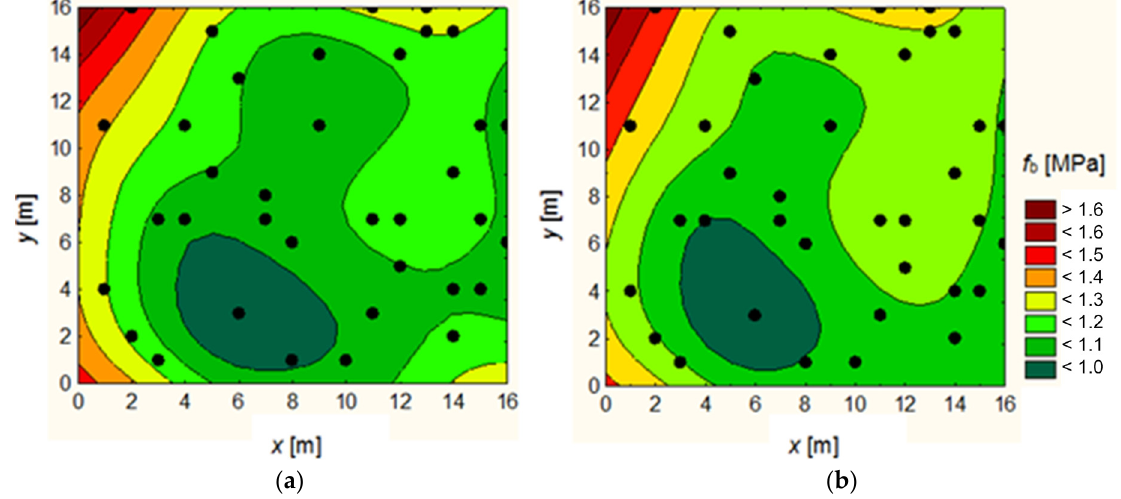
Figure 7. Comparative maps of the value of the f b , based on validation results yielded by: ( a ) the pull-off method; ( b ) the ICA-ANN model (the symbol “ • ” represents a randomly-selected test point used for validation).